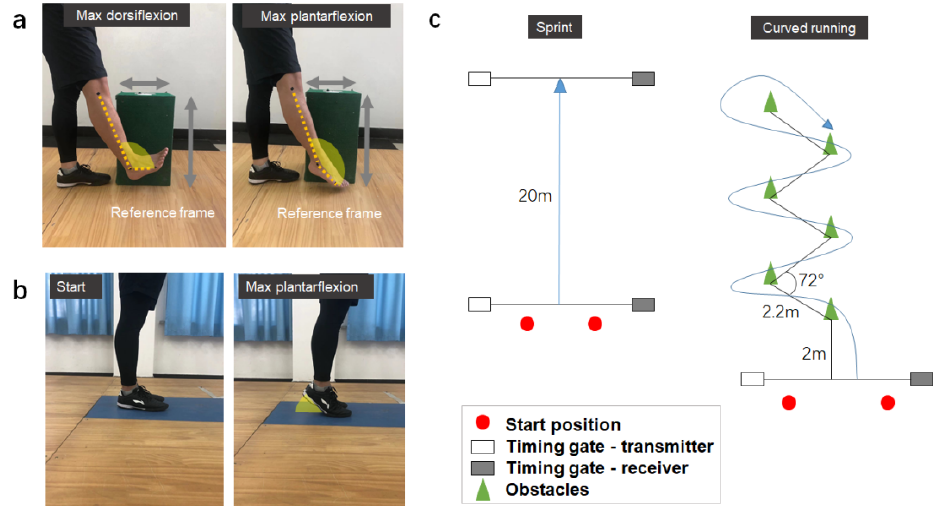
Figure 2. Experimental protocols for ( a ) flexibility test, ( b ) standing heel raise test (dynamic balance and muscle strength) and ( c ) functional performance test (sprinting and curved running).